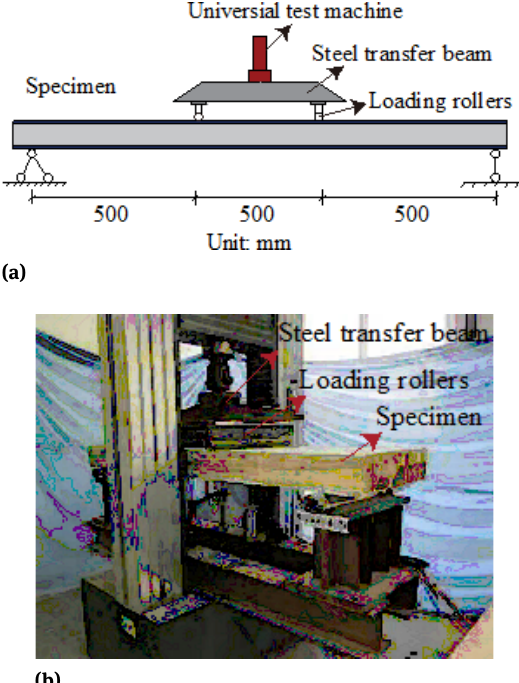
Figure 7: Four-point bending test set-up of sandwich panel: (a) schematic illustration of flexural of sandwich panel (b) experimental